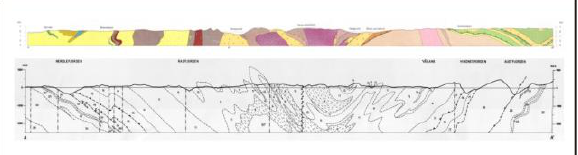
Figure 1. Examples of 250K and 50K profiles showing the difference in quality.